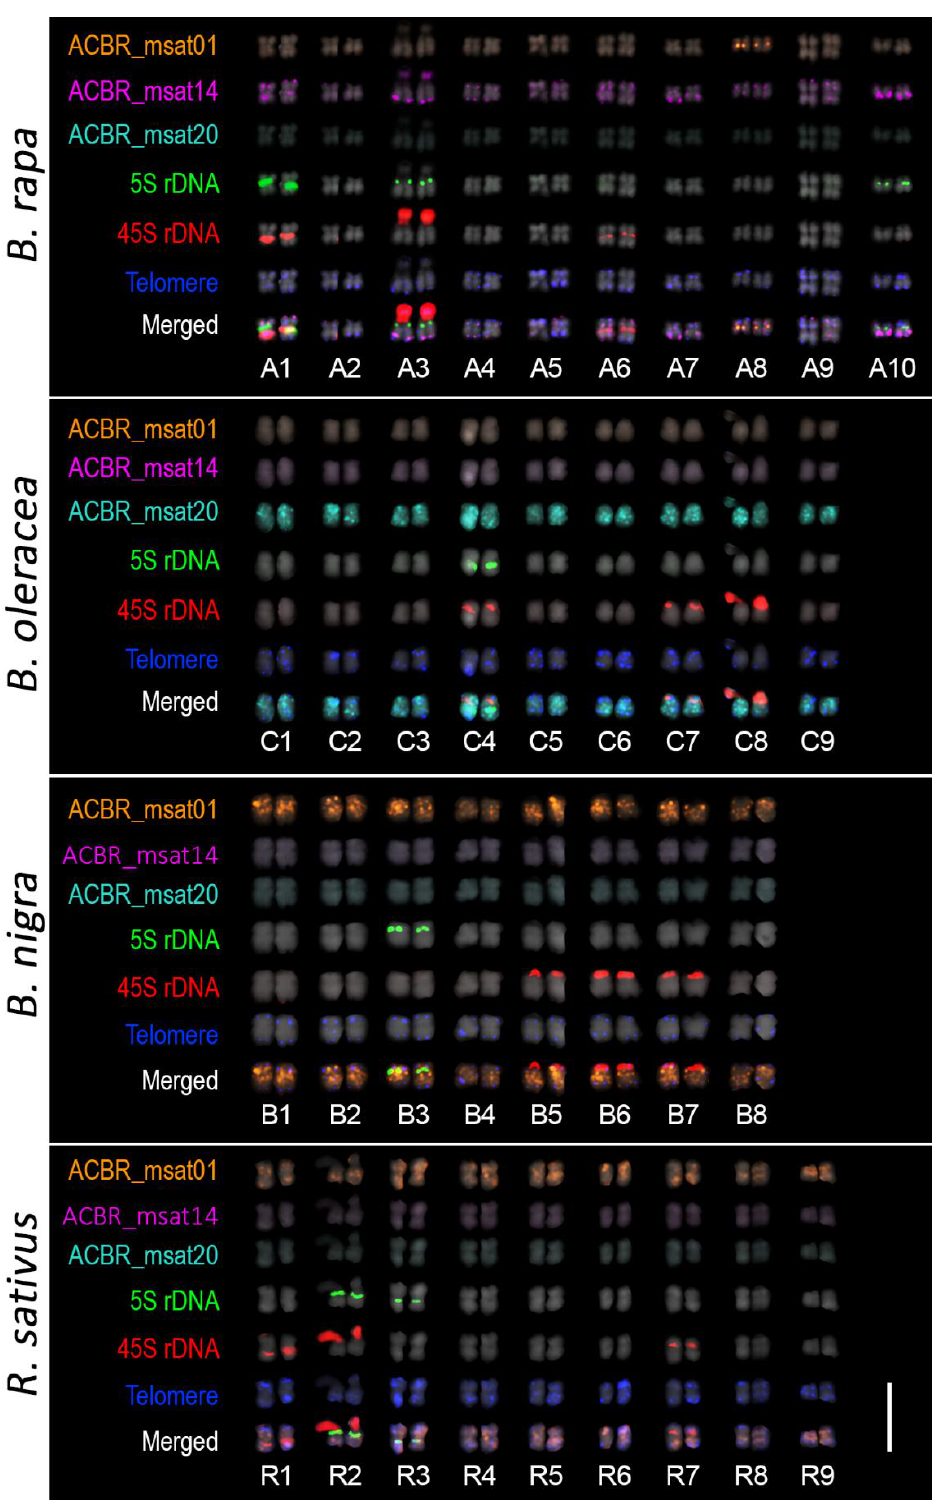
Figure 3. Karyogram of B. rapa , B. oleracea , B. nigra , and R. sativus chromosomes from Figure 2.